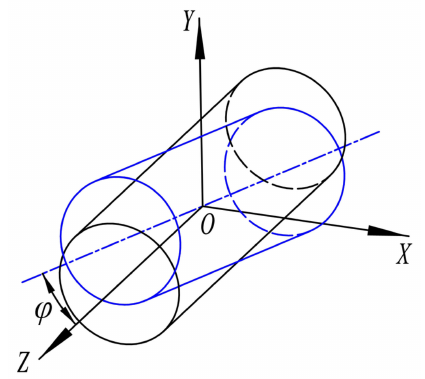
Figure 15. Schematic of the askewing